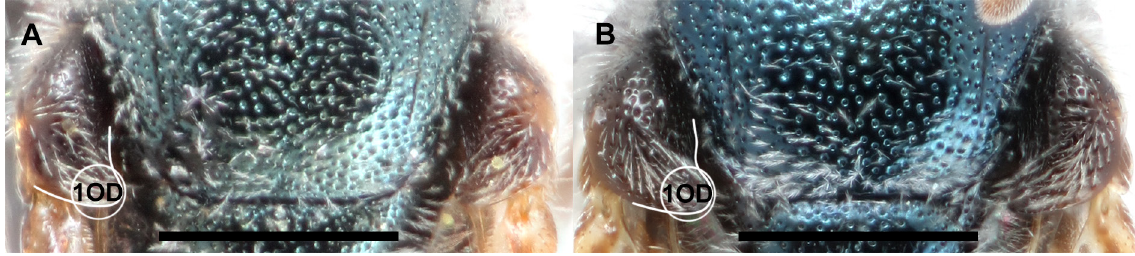
Fig. 110. Tegulae. A . Lasioglossum helianthi (Cockerell, 1916), ♂, with smaller posterior projection (outline on left) barely exceeding mesoscutum posterior margin. B . L. angelicum sp. nov., ♂, with larger posterior projection (outline on left) clearly exceeding mesoscutum posterior margin. The white circle corresponds to 1 lateral OD. Scale bars = 0.5 mm.